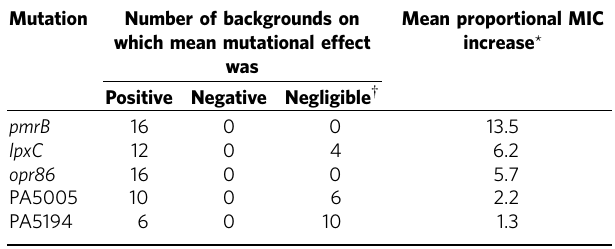
Table 1 | Effects on colistin resistance of mutations from strain SNRC in the 16 possible allelic backgrounds.